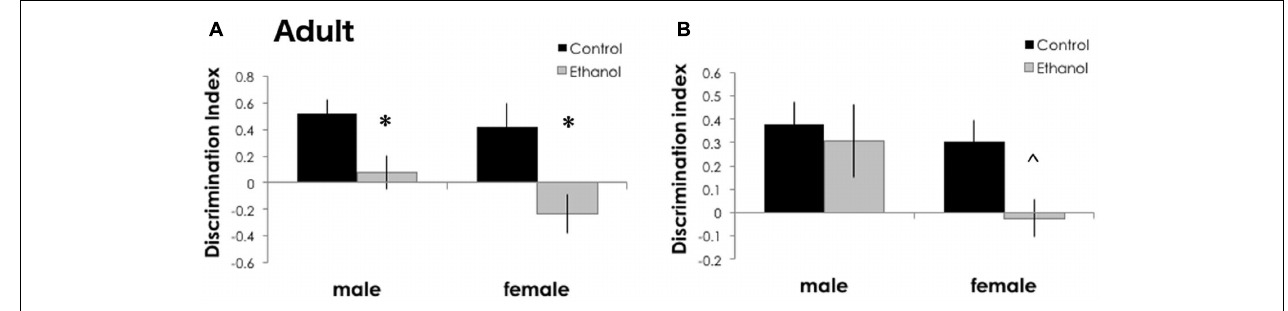
FIGURE 3 | Recognition memory was impaired in adult mice after binge ethanol in adolescence. After a 5-min delay between training and testing (A) , ethanol-exposed DBA/2J adult mice ( n = 6–11/group) had a zero or negative discrimination index, indicating a failure to recognize a novel object, or failure to remember a familiar object. After a 1-h delay (B) , DBA/2J adult female mice had a trend to a lower discrimination index. Data is presented as mean +/– SEM. ∗ p < 0.05, main effect of treatment by Two-Way ANOVA. ˆ p = 0.07, a trend for a significant effect of treatment.